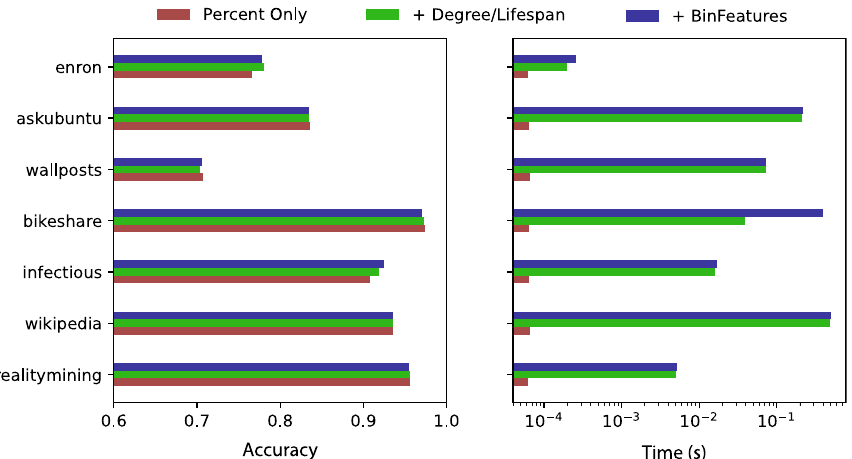
Fig. 7 Prediction accuracy and feature computation times for the 3 feature sets we consider. Using only the node and interval percent features achieves almost the same prediction accuracy as the larger feature sets